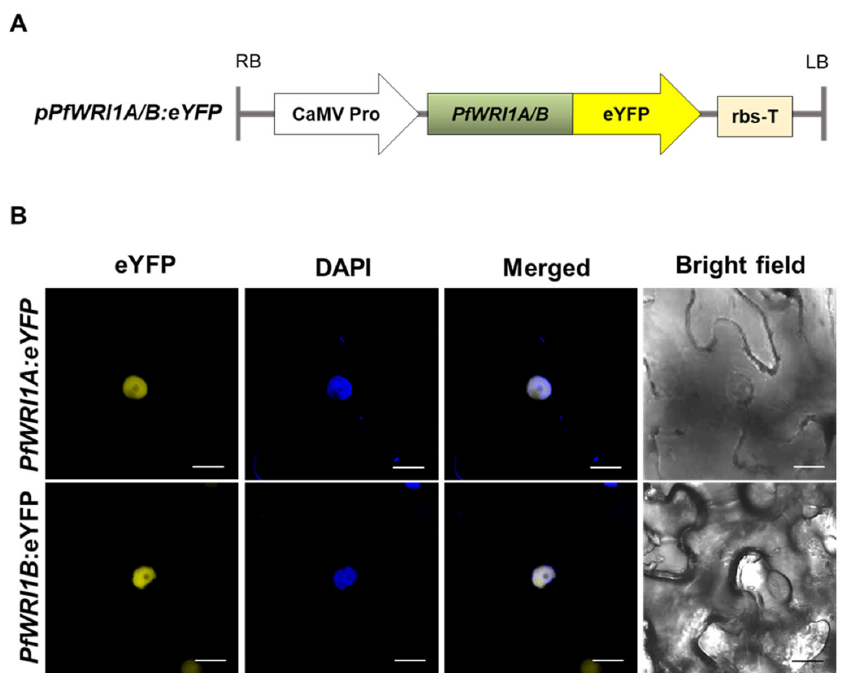
Figure 3. Subcellular localization of PfWRI1s:eYFP in N. benthamiana epidermis. ( A ) Schematic diagram of PfWRI1A : eYFP and PfWRI1B : eYFP constructs. CaMV Pro, cauliflower mosaic virus 35S promoter; LB, left border; RB, right border; rbs-T, the terminator of ribulose-1,5-bisphosphate carboxylase and oxygenase small subunit from pea ( Pisum sativum ). ( B ) Agrobacterium harboring the PfWRI1A : eYFP (upper) or PfWRI1B : eYFP (bottom) construct was infiltrated into N. benthamiana leaves and then the fluorescent signals were visualized under laser confocal scanning microscopy.